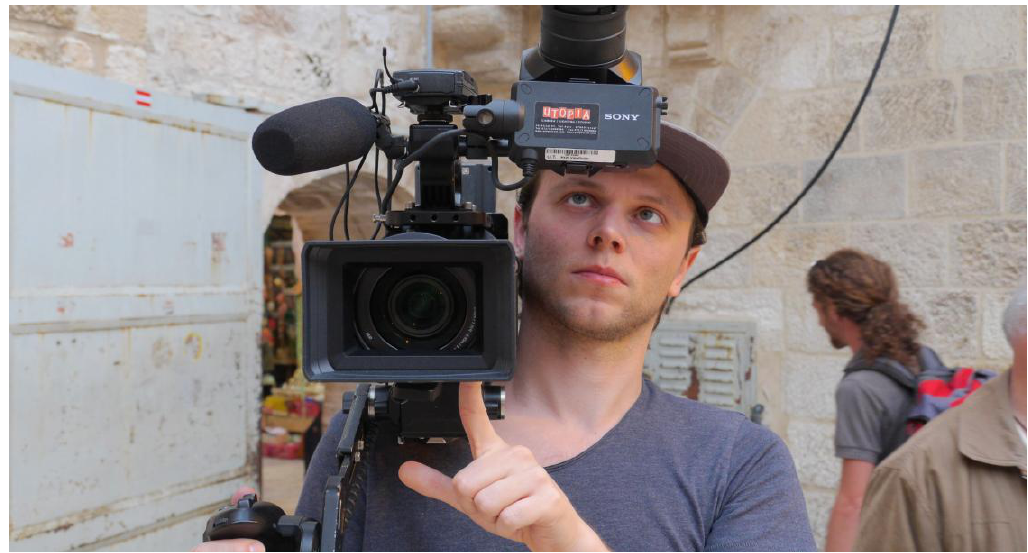
Figure 3. Director Andrés Lübbert. Picture courtesy of Andrés Lübbert.